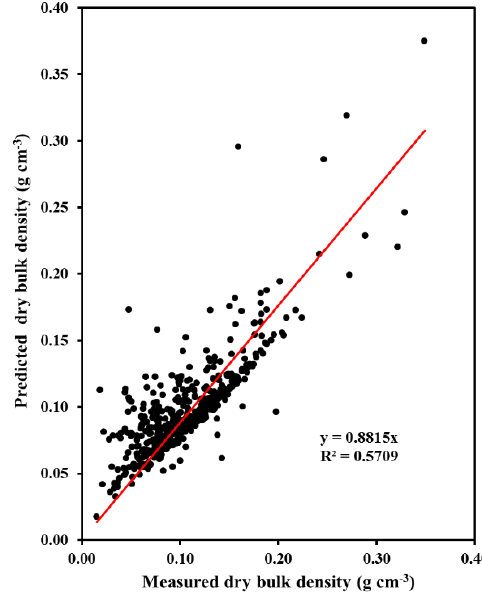
Figure A4. Regression of predicted dry bulk density on measured dry bulk density for a set of Indonesian intact peat swamp forest peats, omitting samples taken at depths less than 100 cm. Standard error of observations = 0.0108, P < 0.001.